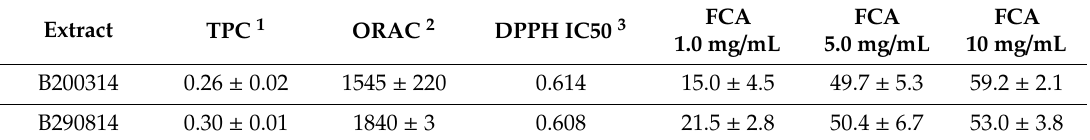
Table 1. Bioactive properties of the Fucus vesiculosus extracts assessed by different chemical assays.